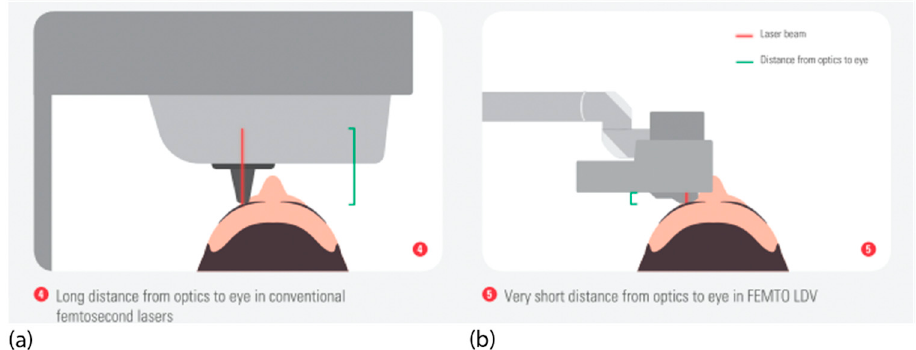
Figure 7. Typical eye docking methods of fs lasers: ( a ) head under fixed laser housing, ( b ) articulated arm with handpiece placed onto the eye; green: distance of eye surface to laser optics.